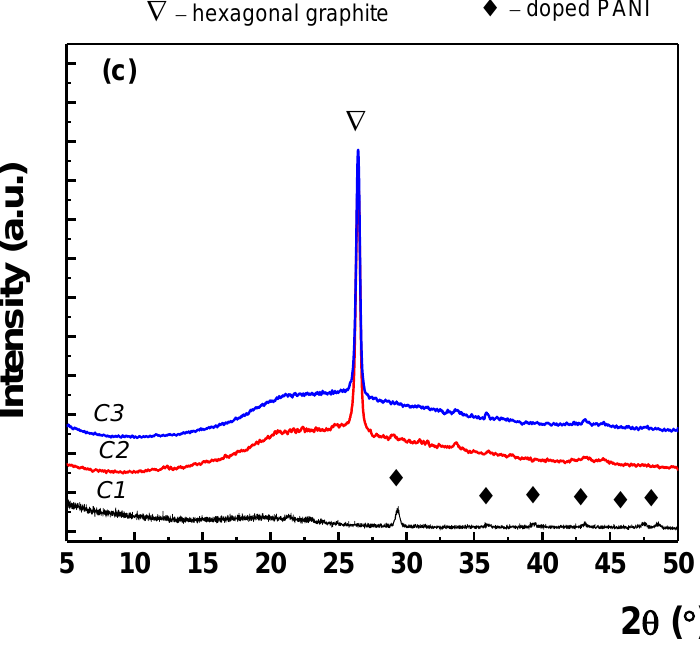
Figure 6. XRD profiles of ( a ) HCl, ( b ) HBr, and ( c ) PSS-doped PANI/graphene/PEDOT:PSS water- based formulation with one, two, and three layers (black, red, and blue, respectively).